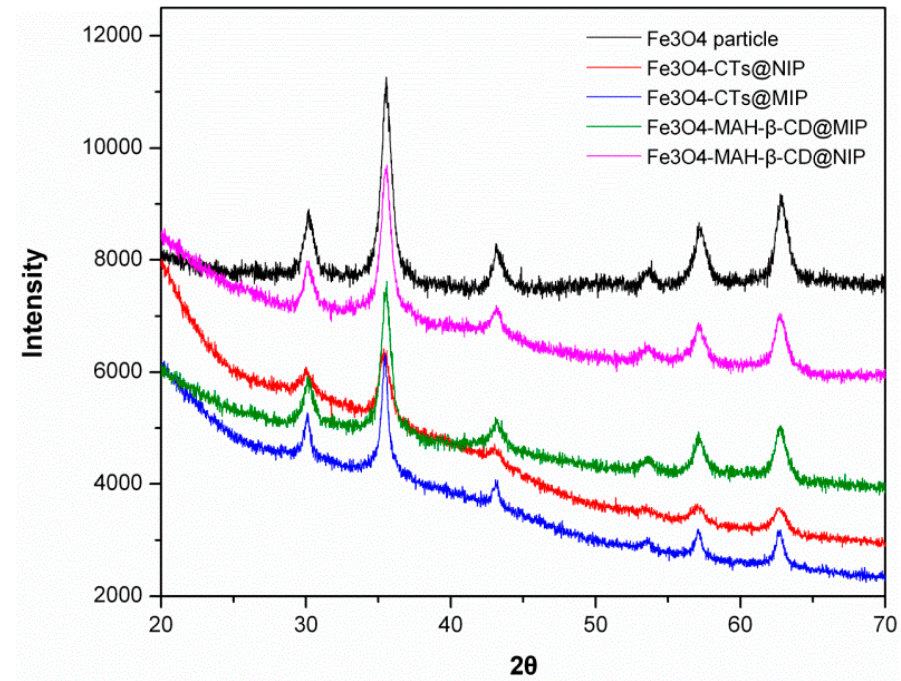
Figure 5. XRPD patterns of Fe 3 O 4 , Fe 3 O 4 -CTs@MIP, Fe 3 O 4 -CTs@NIP, Fe 3 O 4 -MAH- β -CD@MIP and Fe 3 O 4 -MAH- β -CD@NIP.